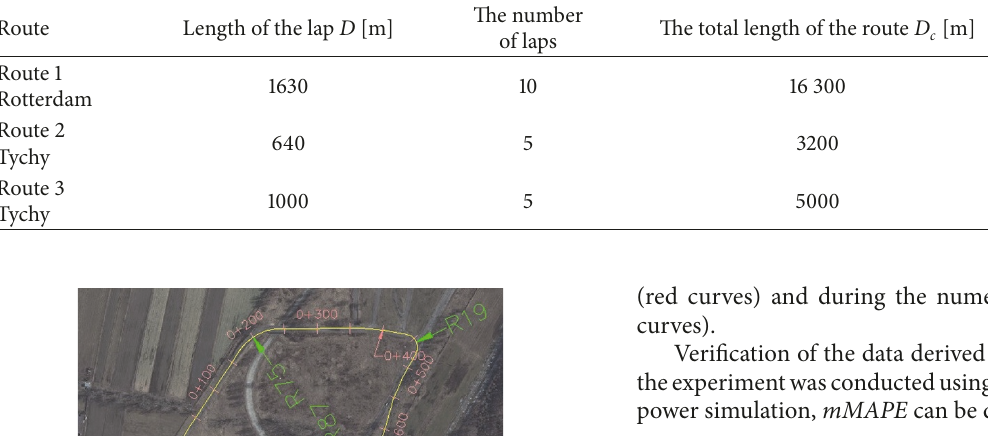
Table 5: Travel times and total lengths of the routes.